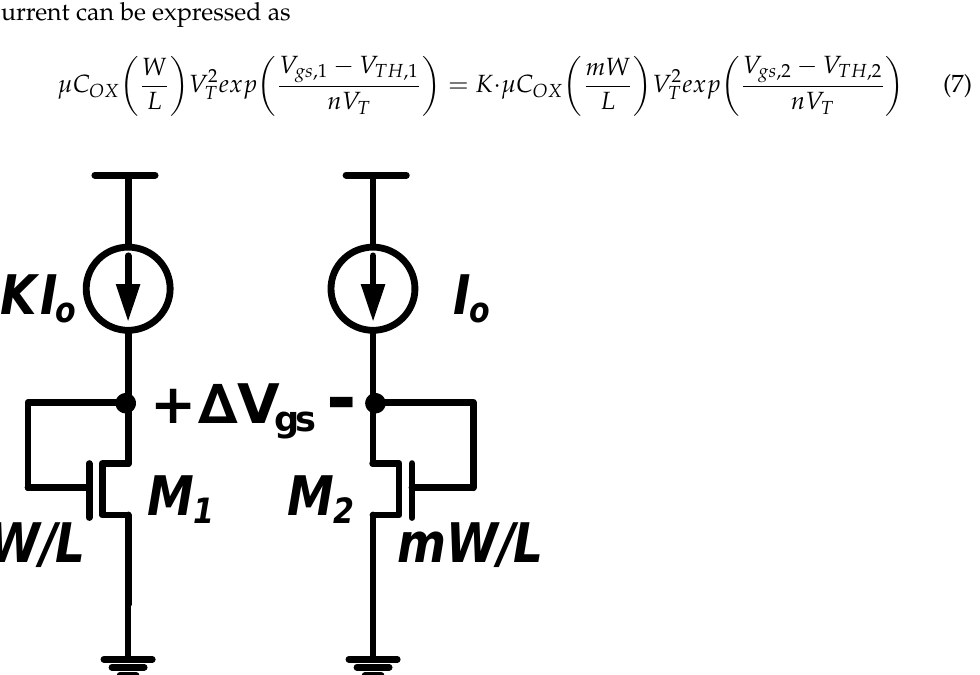
, M ) working in their subthreshold 1 2